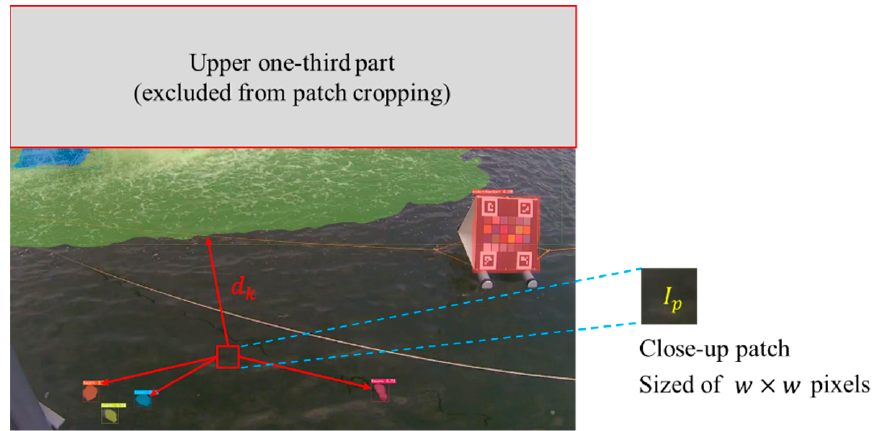
Figure 8. Close-up of an image patch and distances from foams.